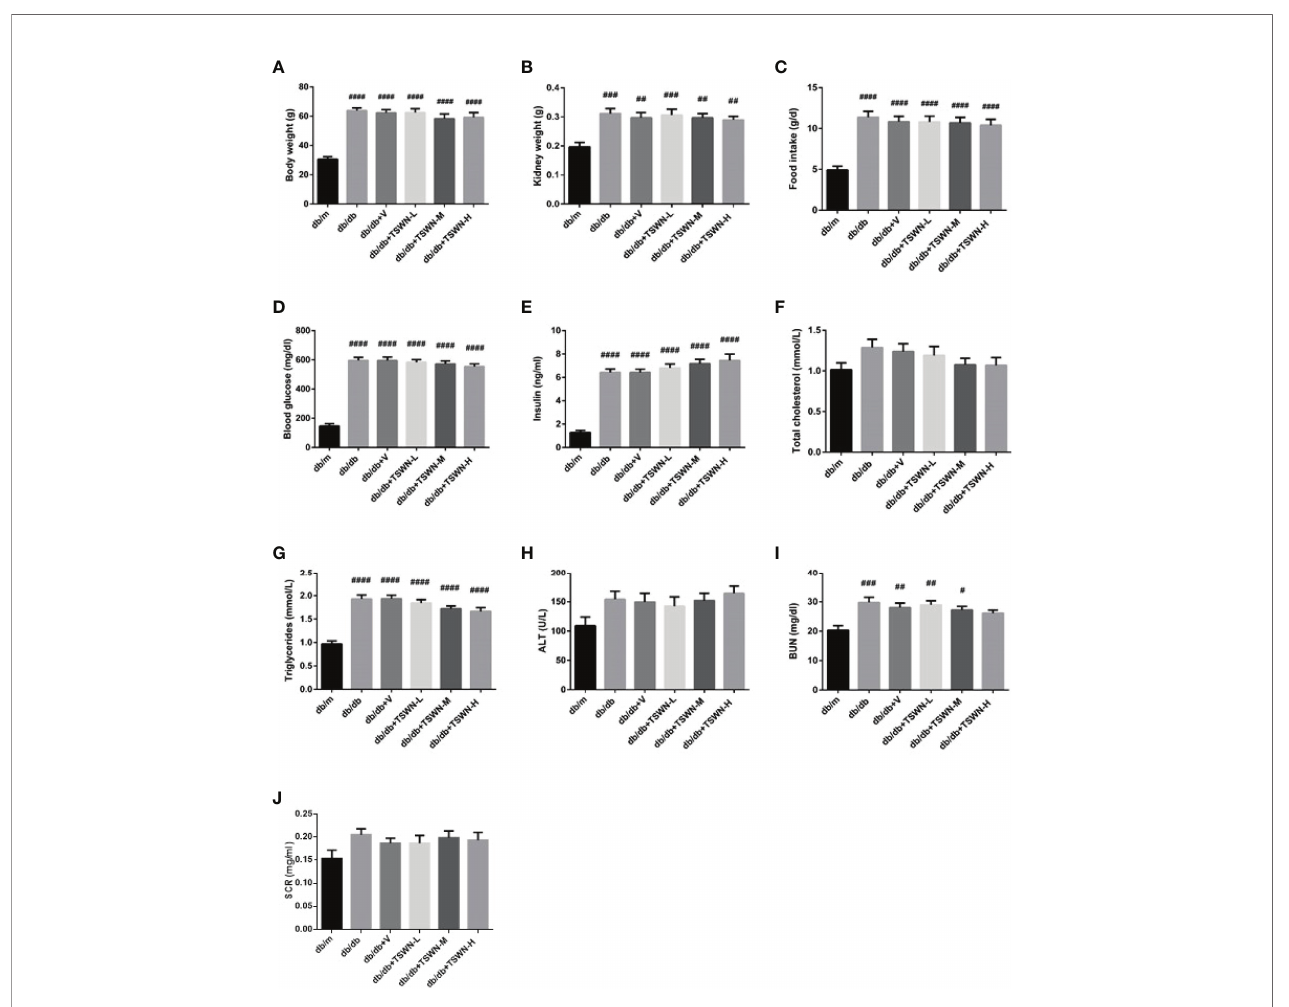
FIGURE 2 | Physical and biochemical characteristics of mice. (A) Body weight. (B) Kidney weight. (C) Food intake. (D) Fasting blood glucose level. (E) Fasting Insulin level. (F) Fasting total cholesterol. (G) Fasting triglycerides. (H) Alanine aminotransferase (ALT). (I) Blood urea nitrogen (BUN). (J) Serum creatinine (SCr). n = 6 mice/group. # P < 0.05, ## P < 0.01, ### P < 0.001, #### P < 0.0001 vs db/m group. Db/m, db/m mice; db/db, db/db mice; db/db+V, db/db mice with valsartan treatment; db/db+TSWN-L, db/db mice with low dose TSWN treatment; db/db+TSWN-M, db/db mice with middle dose TSWN treatment; db/db+TSWN-H, db/db mice with high dose TSWN treatment. Data are means ±